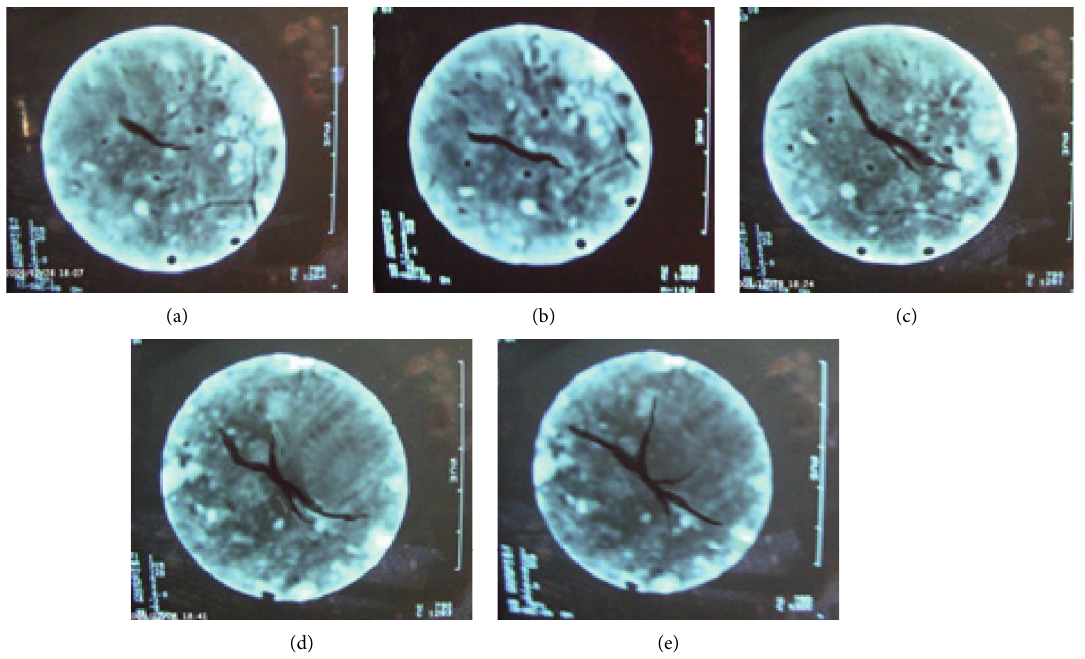
Figure 14: CT images of the a section position of the LC-1 sample with cycle amplitude Δ w � 10%. (a) Zero cycles. (b) One cycle. (c) Two cycles. (d) Four cycles. (e) Six cycles.